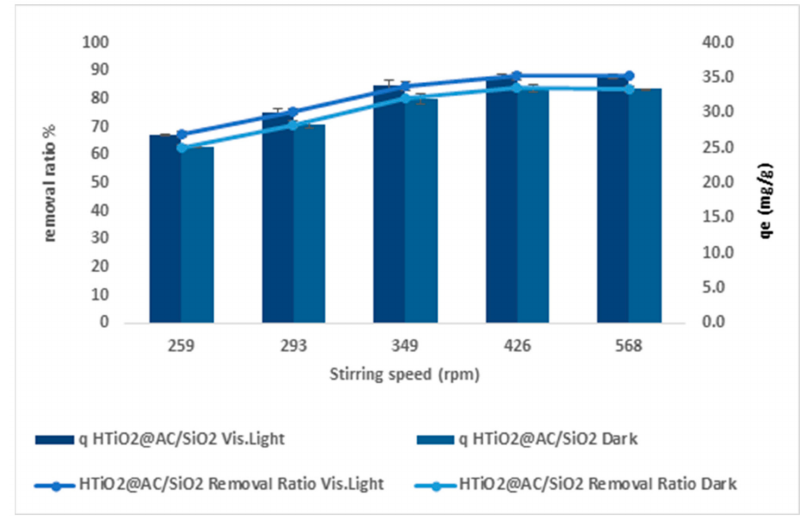
Figure 9. Stirrer rate effect.